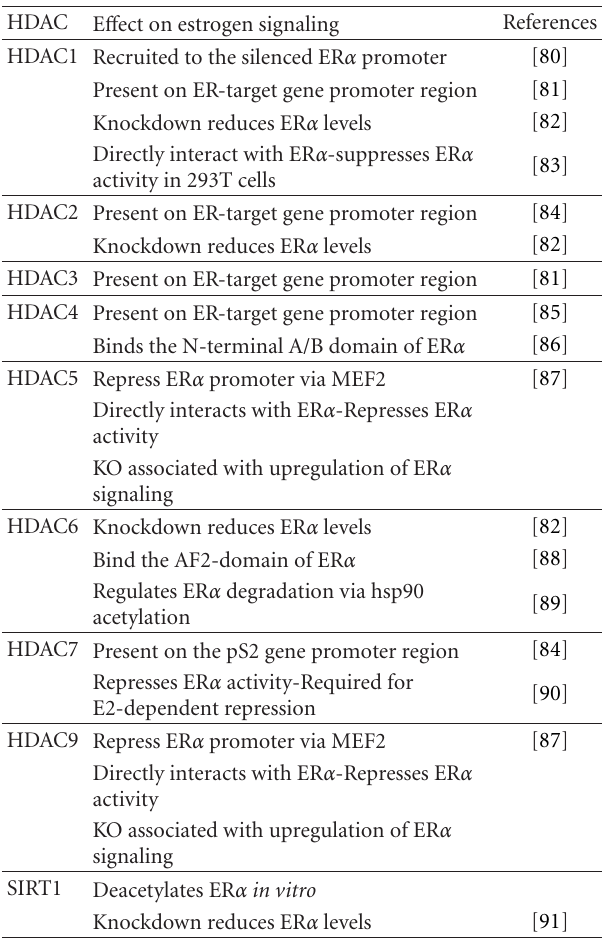
Table 3: HDACs and estrogen signaling. HDAC E ff ect on estrogen